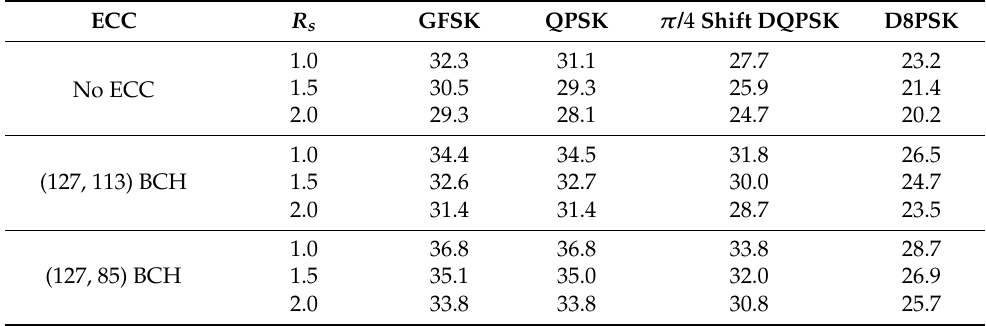
Table 13. Examples of fade margins (dBm). PER ≤ 10 − 3 , L PSDU = 127 bytes, NF dB = 13 dB and I dB = 6